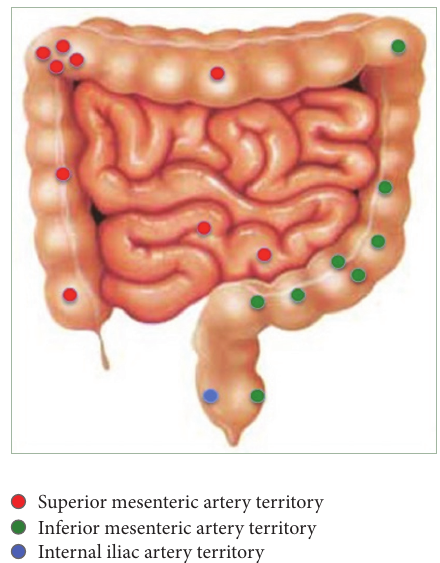
Figure 3: Location of bleeding sites by vascular